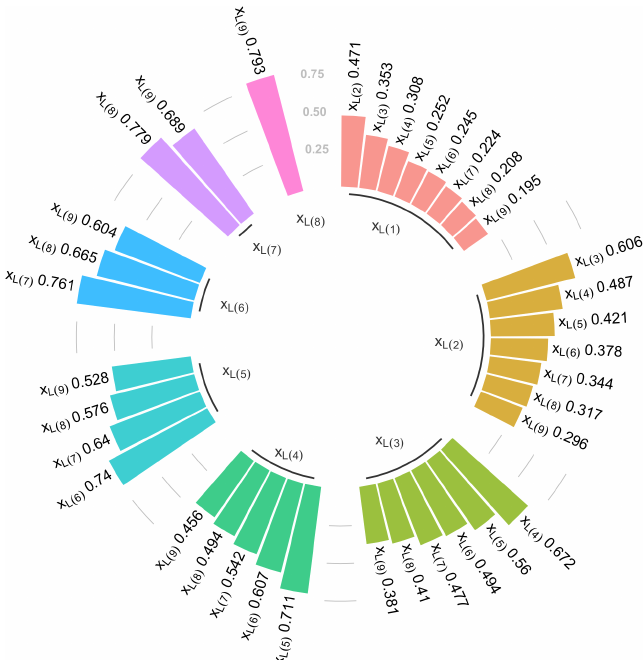
Figure 5. Circular plot for Kendall’s τ between two paired record values.